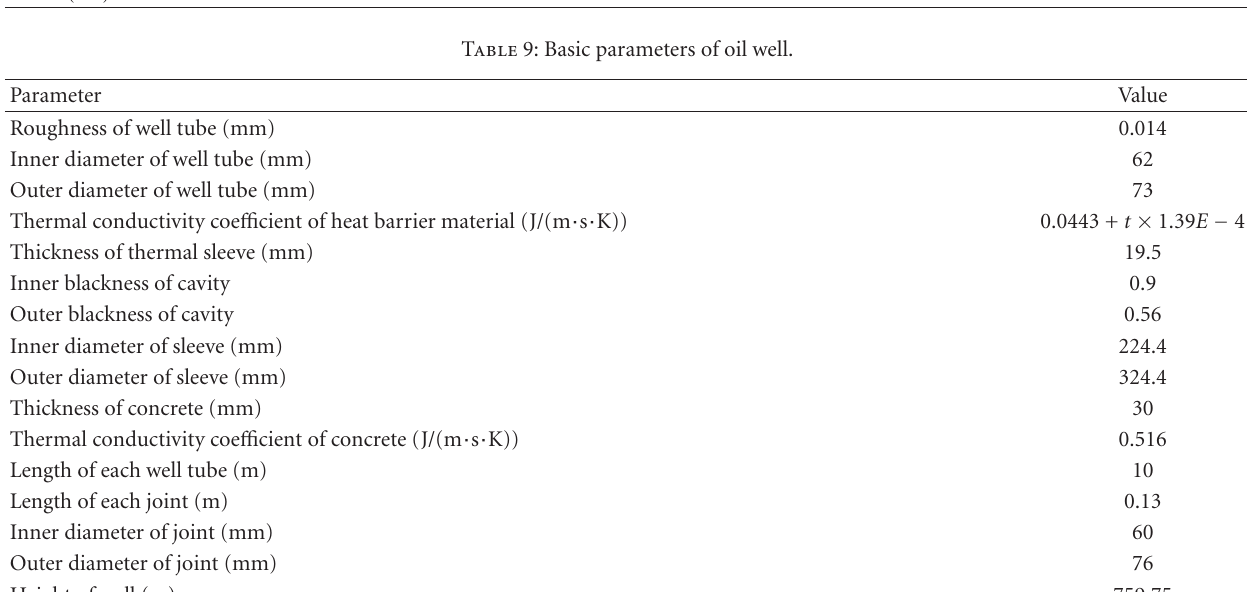
Table 9: Basic parameters of oil well.